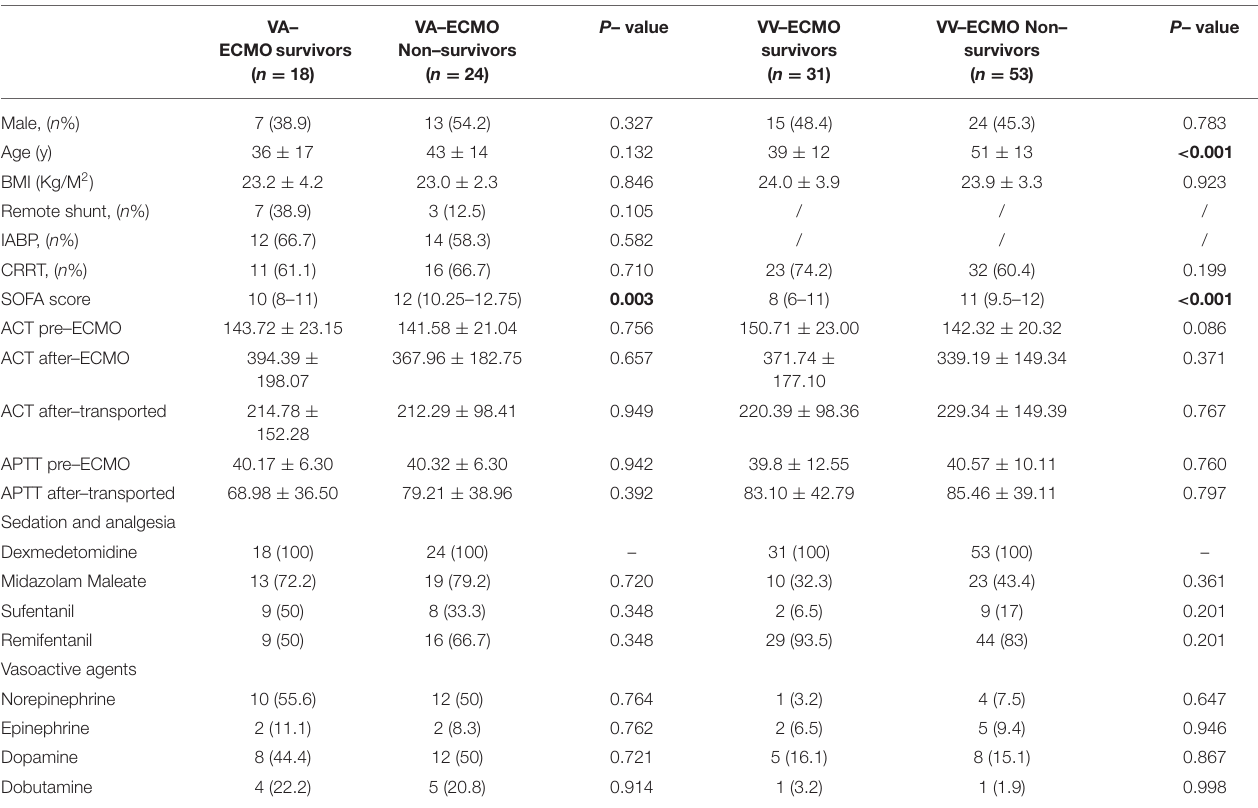
TABLE 2 | Comparison of the characteristics of the survivors and non-survivors of VA-/VV-ECMO. VA– ECMOsurvivors